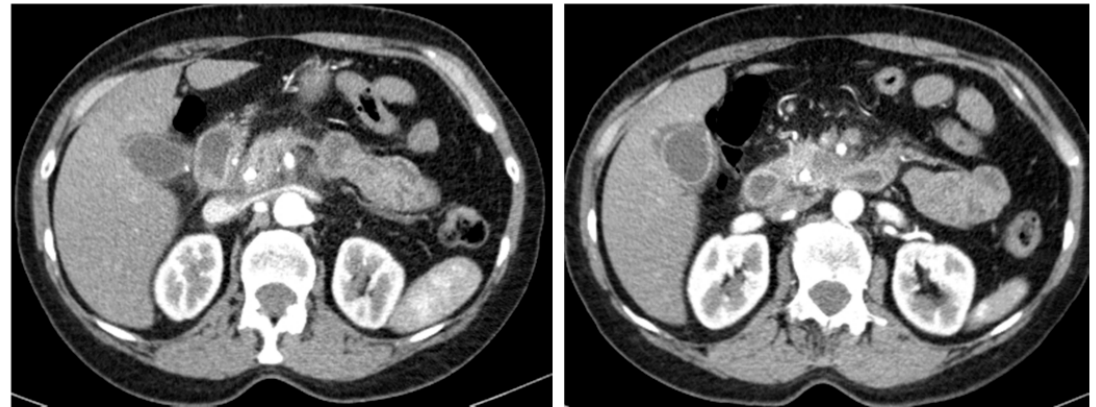
Figure 2. CT examination (pancreatic phase) of ductal adenocarcinoma of the pancreatic head with the presence of the perivascular cuff surrounding the superior mesenteric artery.